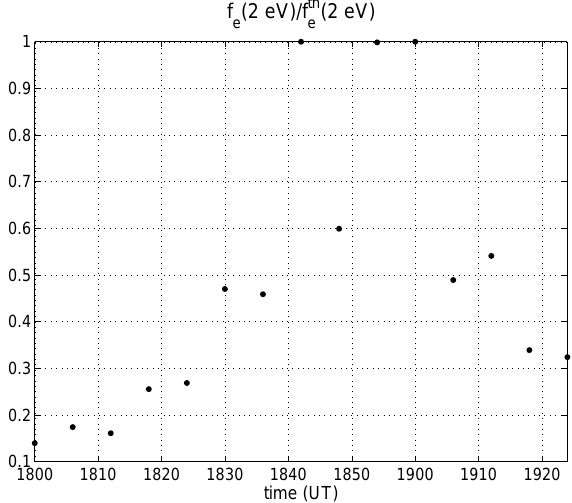
Fig. 6. Electron energy distribution as a function of energy.